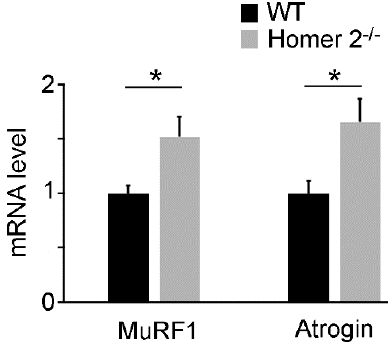
Figure 2. Quantitative RT ‐ PCR analysis of mRNA levels for MuRF1 and Atrogin ‐ 1 in SOL from WT and Homer 2 ‐ / ‐ mice. Values are expressed as the fold change over WT after GeNorm normalisation. Each histogram represents the data obtained from 8 different animals per experimental group. Data are expressed as mean ± SEM. Statistical differences were determined by unpaired t ‐ test. * p < 0.05 vs. the respective WT control.